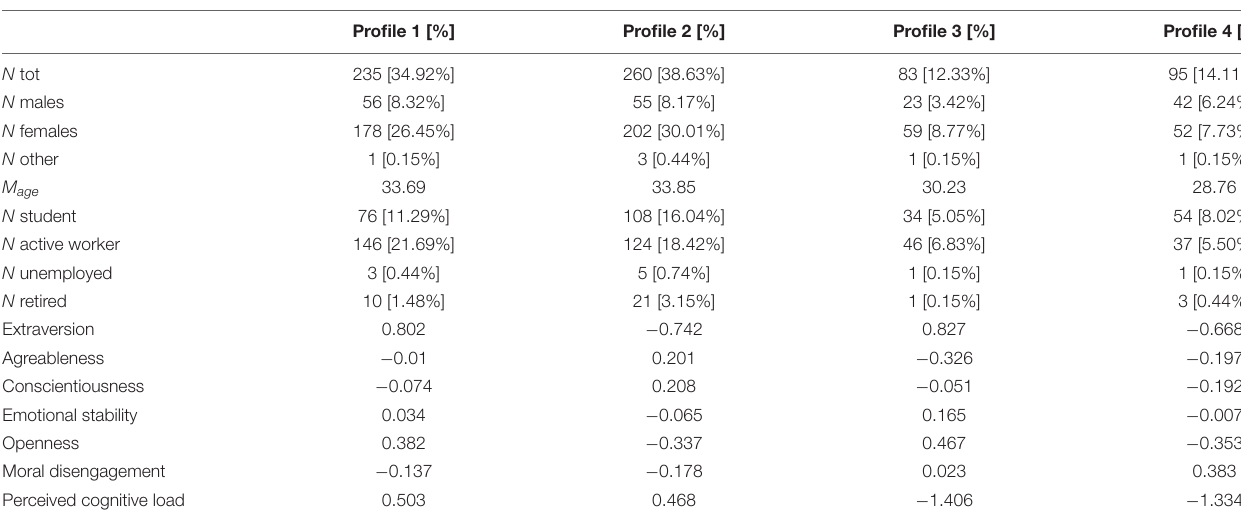
TABLE 2 | Demographic characteristics of each of the four